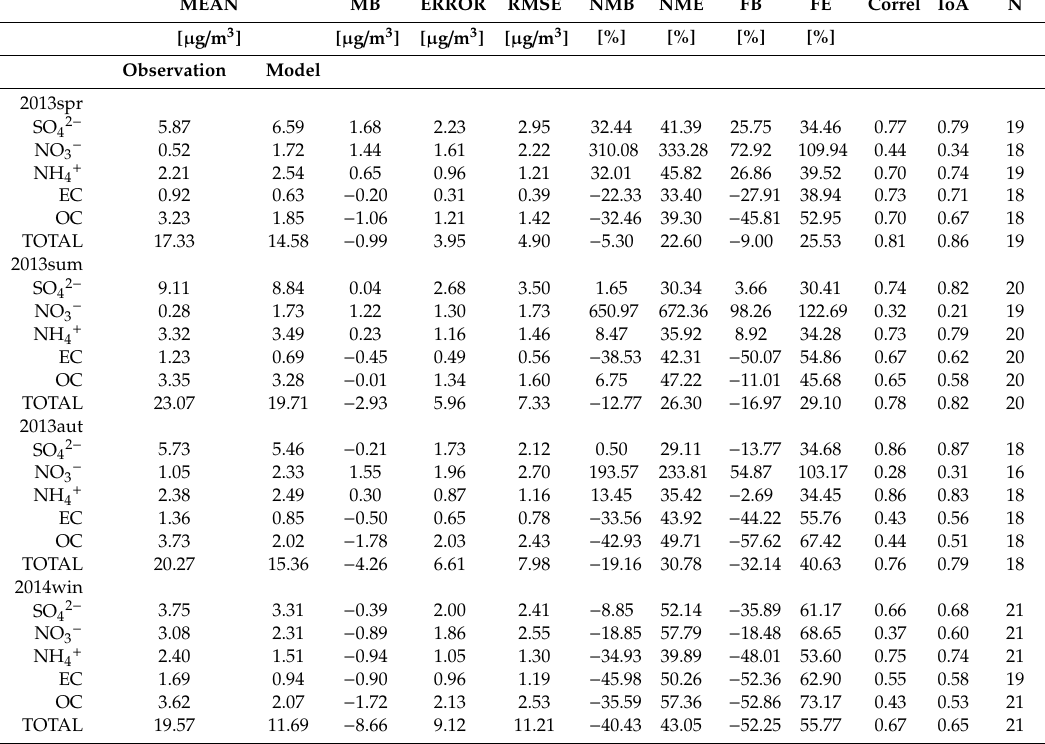
Table 4. Observed and simulated averaged concentrations 1 and ensemble performances 2 of the participant CTMs for daily concentrations of total PM 2.5 and PM 2.5 components at each AAPMS within d03.